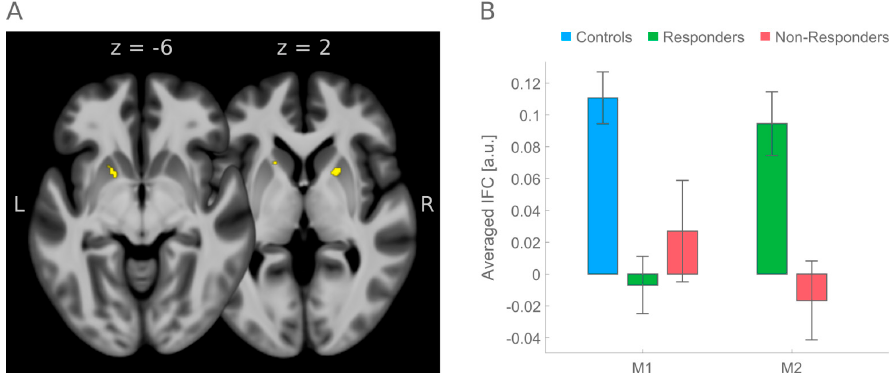
Figure 2. ( A ) Medication effect in left and right putamen superimposed on transversal slices from the mean 3D T1-weighted MPRAGE image in stereotactic MNI space, averaged across all partici- pants (N = 103). For purposes of better visibility of the medication effect from the combined hypoth- esis testing, the resultant SPM was thresholded at a level of p < 0.001, uncorrected at the voxel level; exact statistics with family wise error rate correction at the voxel level are summarized in Table 2. Visualization of effects was performed with MRIcroGL [22] . The mean T1 image was computed with CAT12 (http://www.neuro.uni-jena.de/cat; last accessed: 21 March 2022); ( B ) Bar charts, cre- ated with Gramm [23] , summarize mean and standard error of the mean (SEM) of IFC, averaged